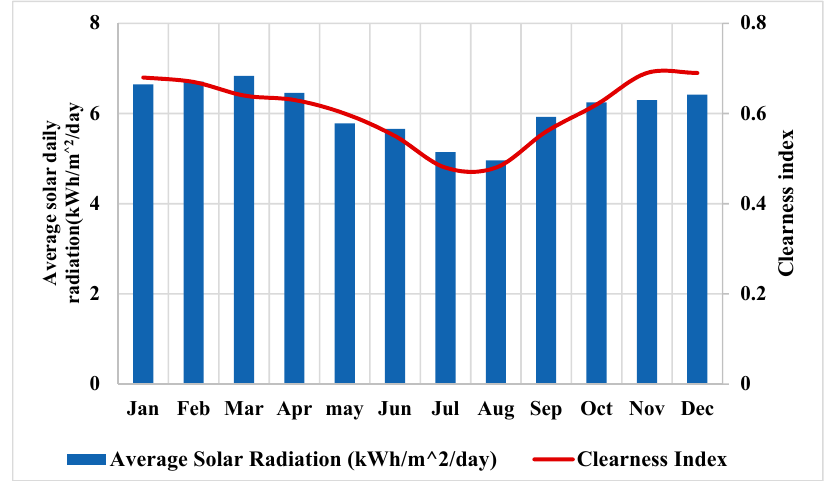
Figure 6. Average daily solar radiation of the school site in each month in 2018.